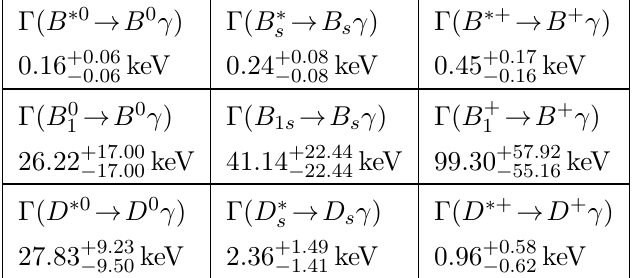
Table 11 . Decay rates based on the g -couplings in table 7 and the decay rate formula